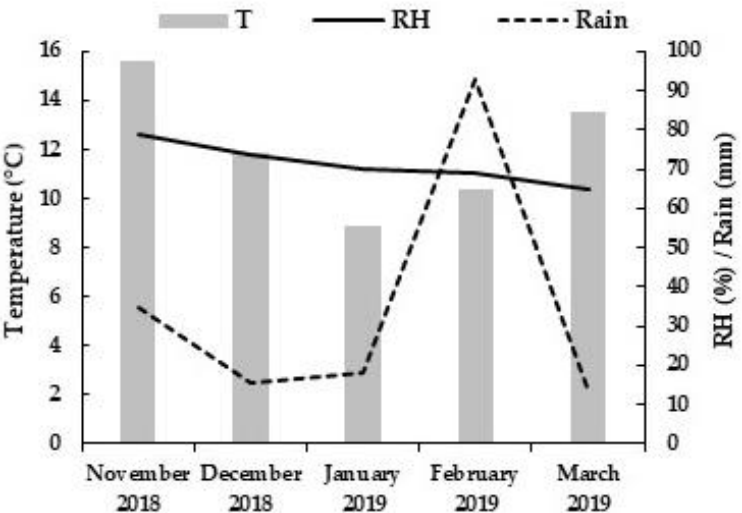
Figure 4. Climate data from March 2018 to March 2019, by the weather station of Francofonte (CT), Sicily. T = Temperature; RH = Relative humidity.